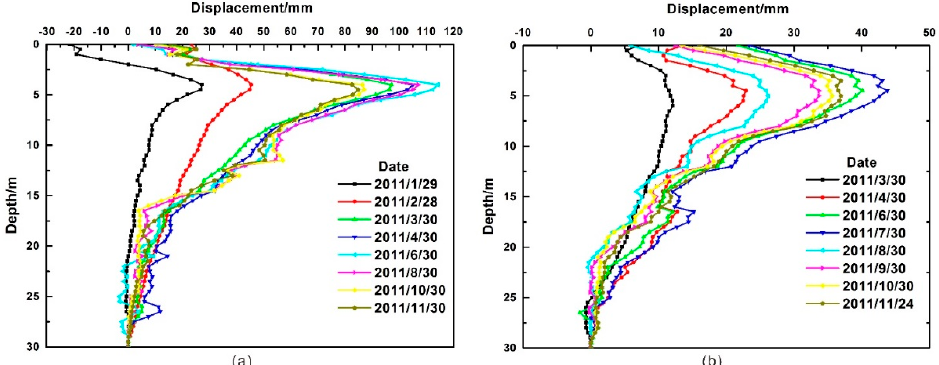
Figure 4. Deep horizontal displacement: ( a ) CX1-1; ( b ) CX1-2.